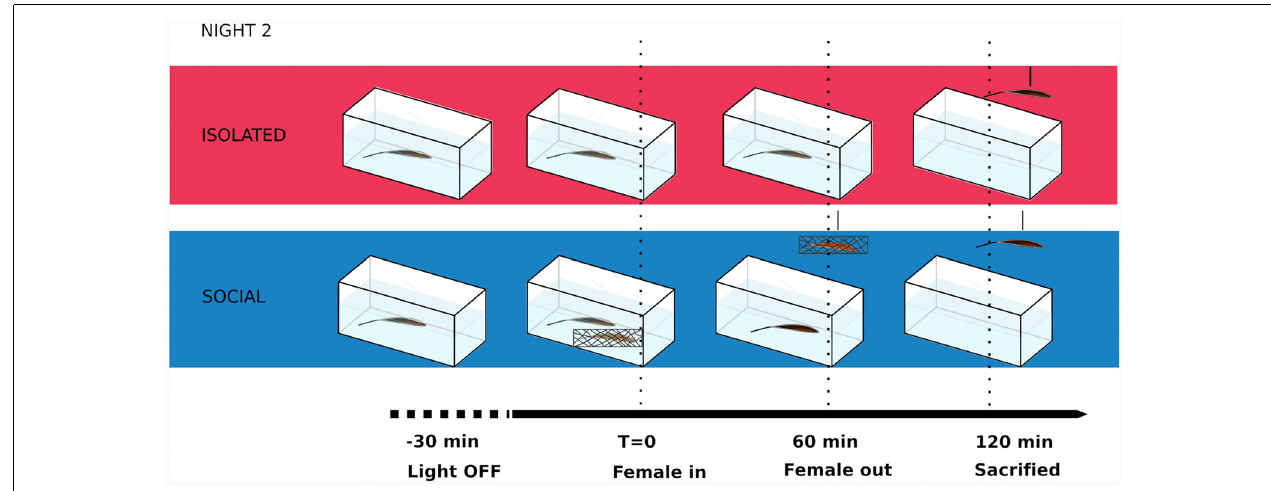
FIGURE 1 | Schematic of behavioral paradigm during the second night in courting males of Brachyhypopomus gauderio . T,